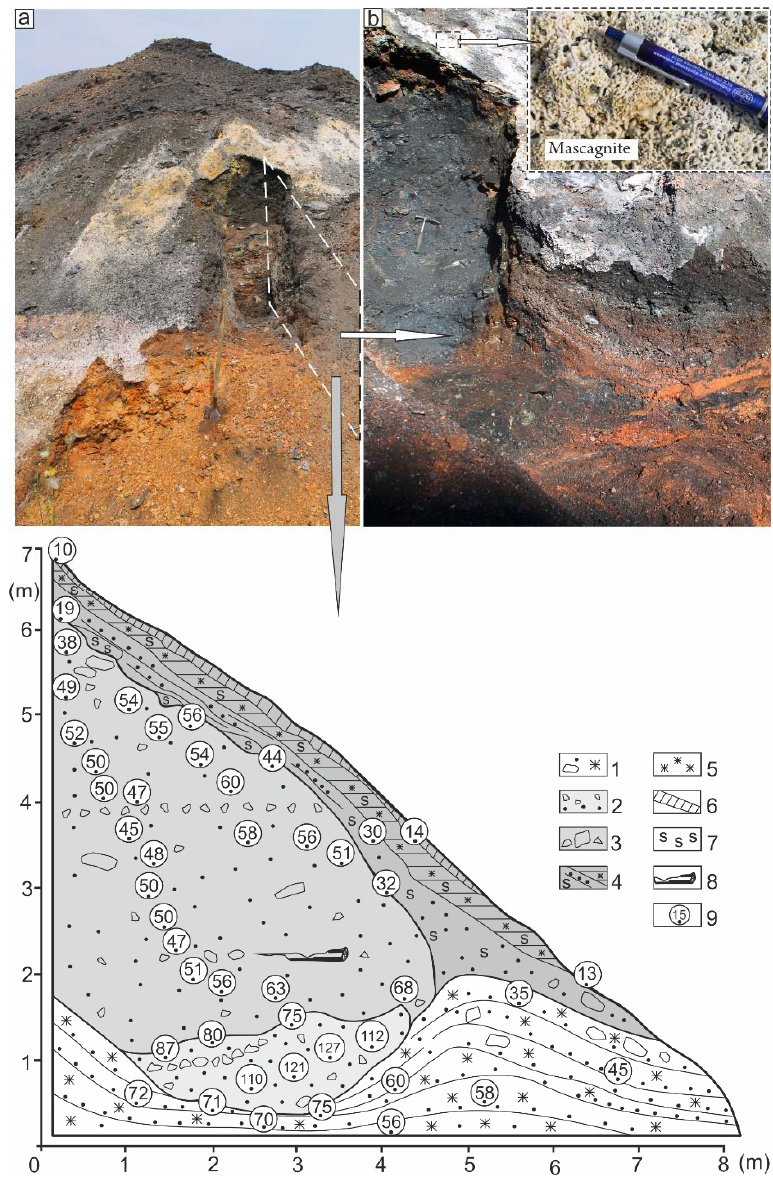
Figure 3. Sketch sectional drawing of active low-temperature pyrolysis chamber, which shows the pyrolysis zoning and temperature distribution of epigenetically changed coal-bearing rocks (spoil heap Ch-05, the southern hillside). ( a )—general view of the excavation site; ( b )—an enlarged fragment. Below is a schematic side profile of fragment b with temperature readings over the profile area. 1—metamorphic zone; 2—heat (focal) zone; 3—activated zone; 4—enriched zone; 5—areas impregnated with light brown ferrum hydroxides; 6—areas of concentration of white mascagnite (NH 4 ) 2 SO 4 ; 7—areas of crystallized sulphur clusters, 8—the location of activated wood, 9—rock temperature measured with pyrometer, the point in the circle indicates the measurement location.